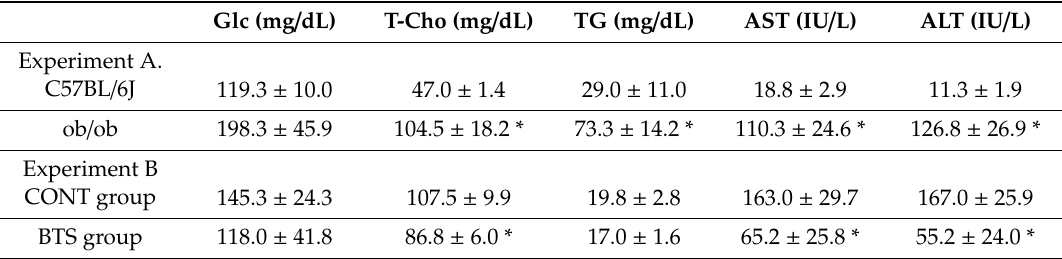
Table 1. Plasma metabolic parameters.